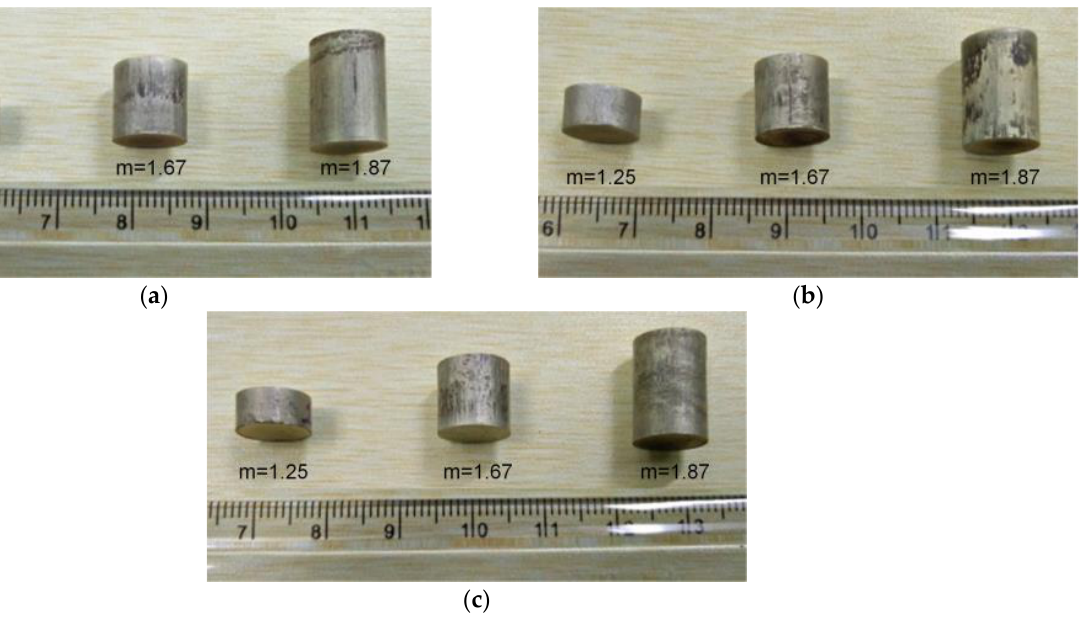
Figure 2. Powder metallurgy (PM)-based Al/7 vol.% SiCp composites (m = 1.25, 1.67 and 1.87) sintered at 700 °C for ( a ) 30 min, ( b ) 60 min and ( c ) 90 min.